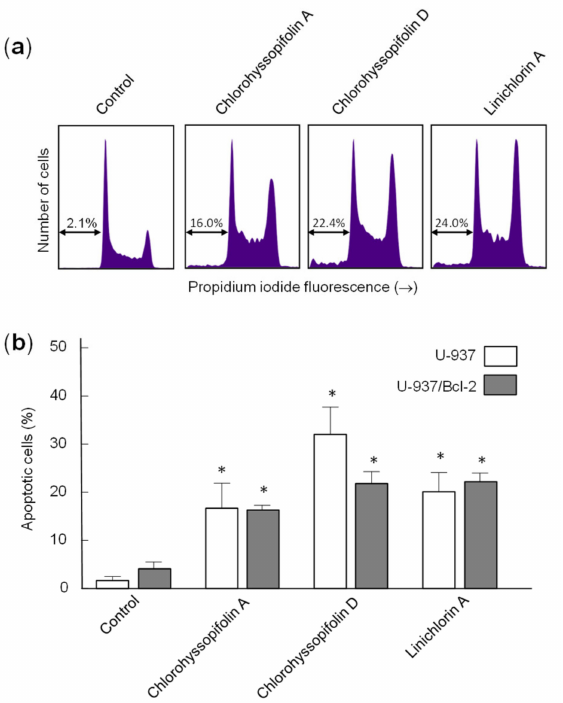
Figure 6. ( a ) Representative histograms obtained by flow cytometry after staining the U-937 / Bcl-2 cells with propidium iodide. ( b ) Cells were incubated in the absence or presence of the indicated guaianolides at10 µ Mconcentrationfor24handthepercentagesofapoptoticcellsweredeterminedbyflowcytometric analysis after propidium iodide staining. Bars represent means ± S.D. of two independent experiments each performed in triplicate. * p < 0.05, significantly di ff erent from untreated